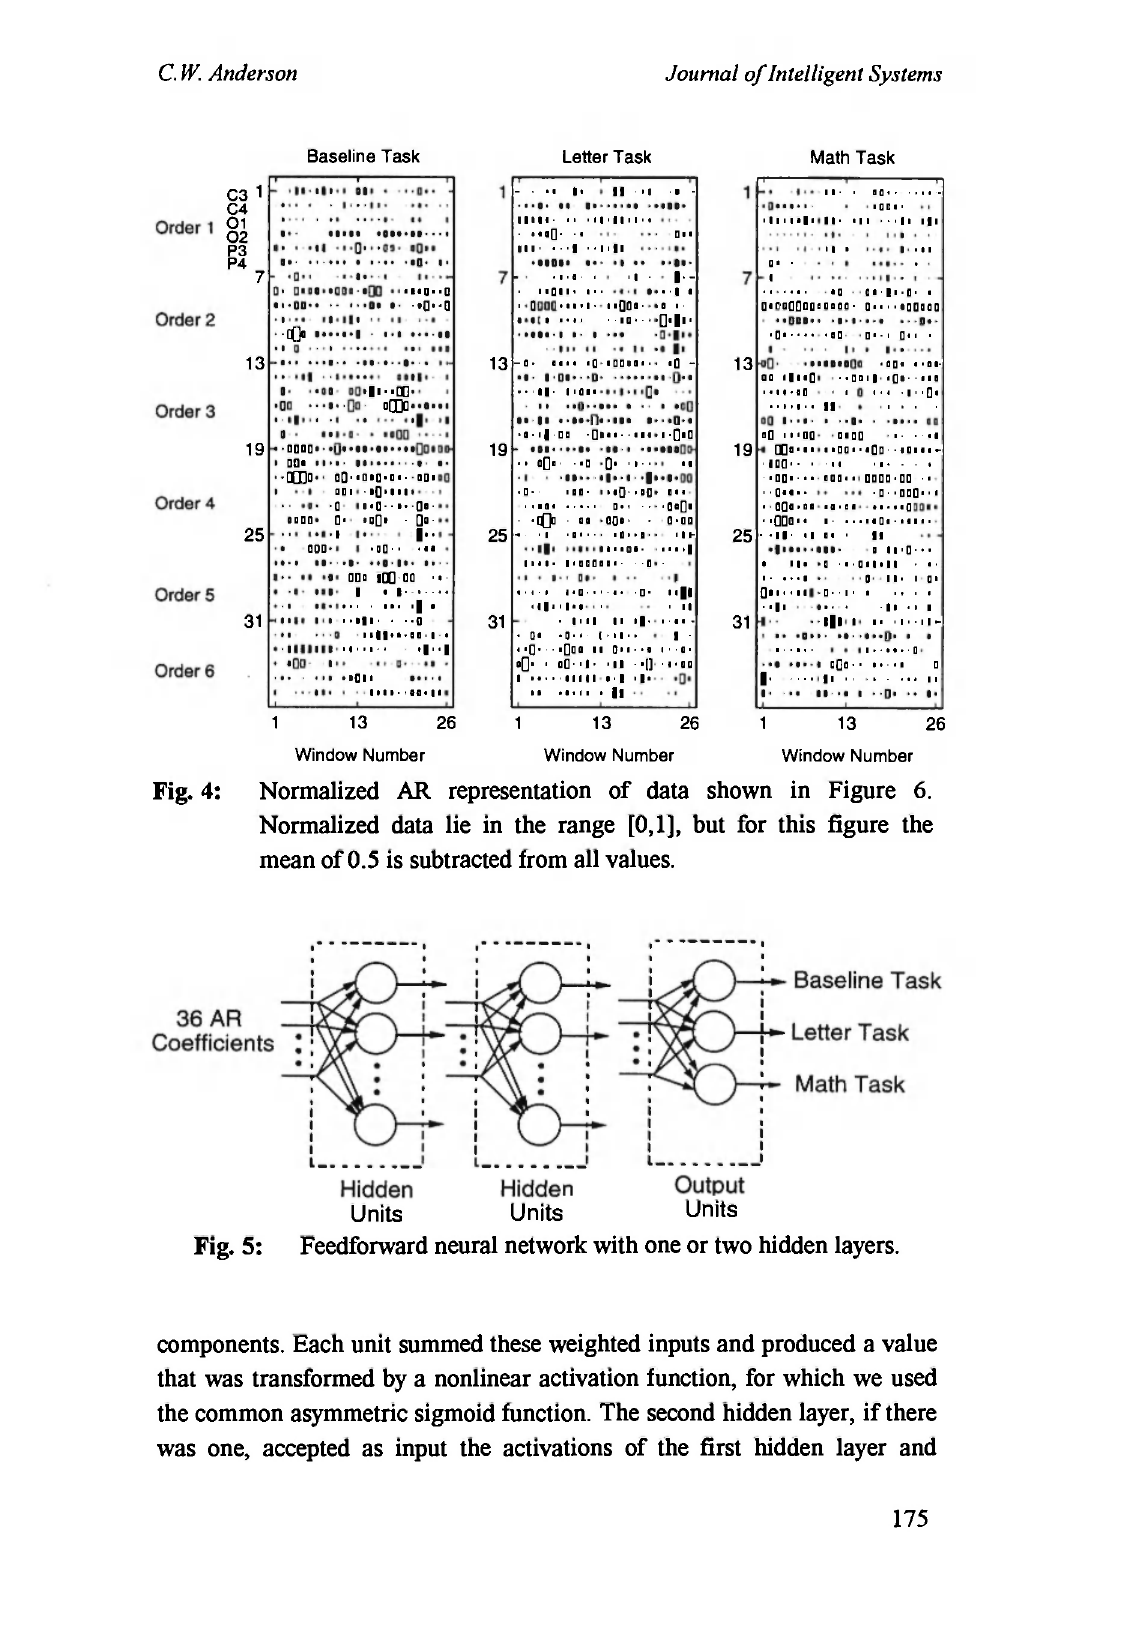
components. Each unit summed these weighted inputs and produced a value that was transformed by a nonlinear activation function, for which we used the common asymmetric sigmoid function. The second hidden layer, if there was one, accepted as input the activations of the first hidden layer